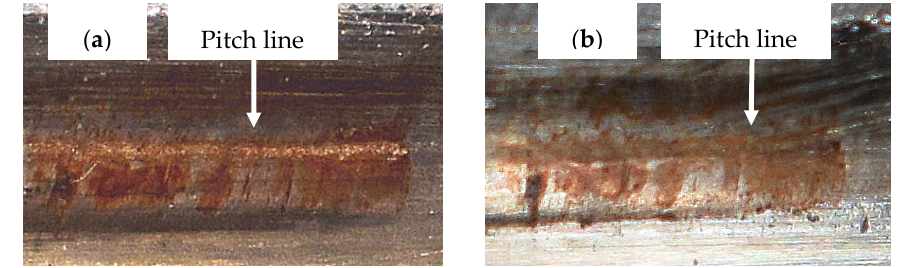
Figure 2. Scuffing on gear tooth surfaces of the tested gear. ( a ) Scuffing marks on one tooth surface; ( b ) Scuffing markers on the other tooth surface.